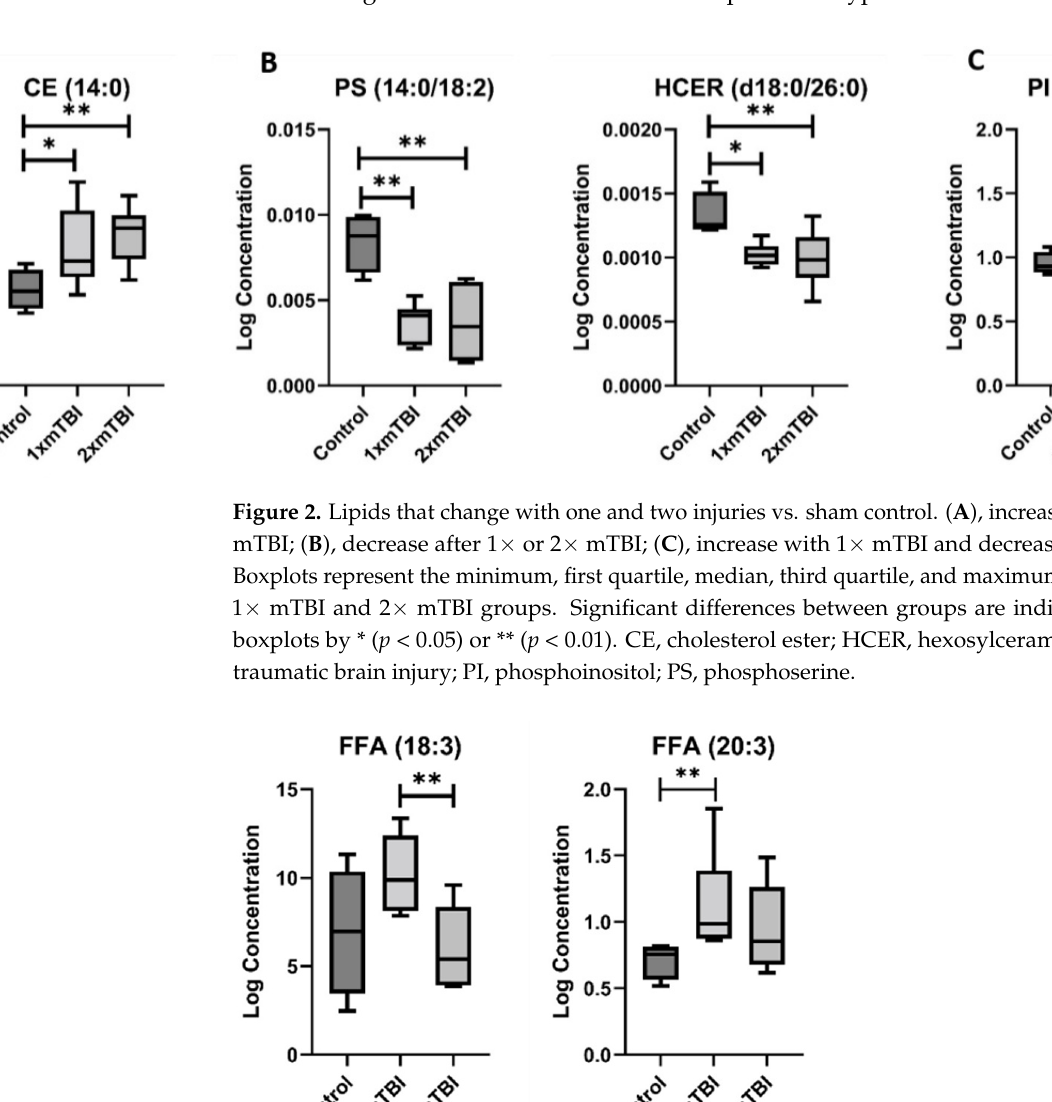
Figure 4. Lipids that change with two injuries vs. sham control. ( A ), Increase after 2× mTBI; ( B ), decrease after 2× mTBI. Boxplots represent the minimum, first quartile, median, third quartile, and maximum, for the control, 1× mTBI and 2× mTBI groups. Significant differences between groups are indicated above the boxplots by * ( p < 0.05) or ** ( p < 0.01). HCER, hexosylceramide; LPE, lyso- phosphatidylethanolamine; mTBI, mild traumatic brain injury; PC, phosphocholine; PE, phos- phoethanolamine; PI, phosphoinositol. 3. Discussion The metabolic changes associated with mTBI are complex and can have central and peripheral physiological effects. LC-MS can provide unique insight into chemical pertur- bations which occur following TBI [23–25]. Lipids are broadly known to be disturbed fol- lowing TBI. However, the characterisation of alterations in individual lipid species after mTBI is an emerging line of enquiry [10,26,27]. Here, we applied a target lipid screen to